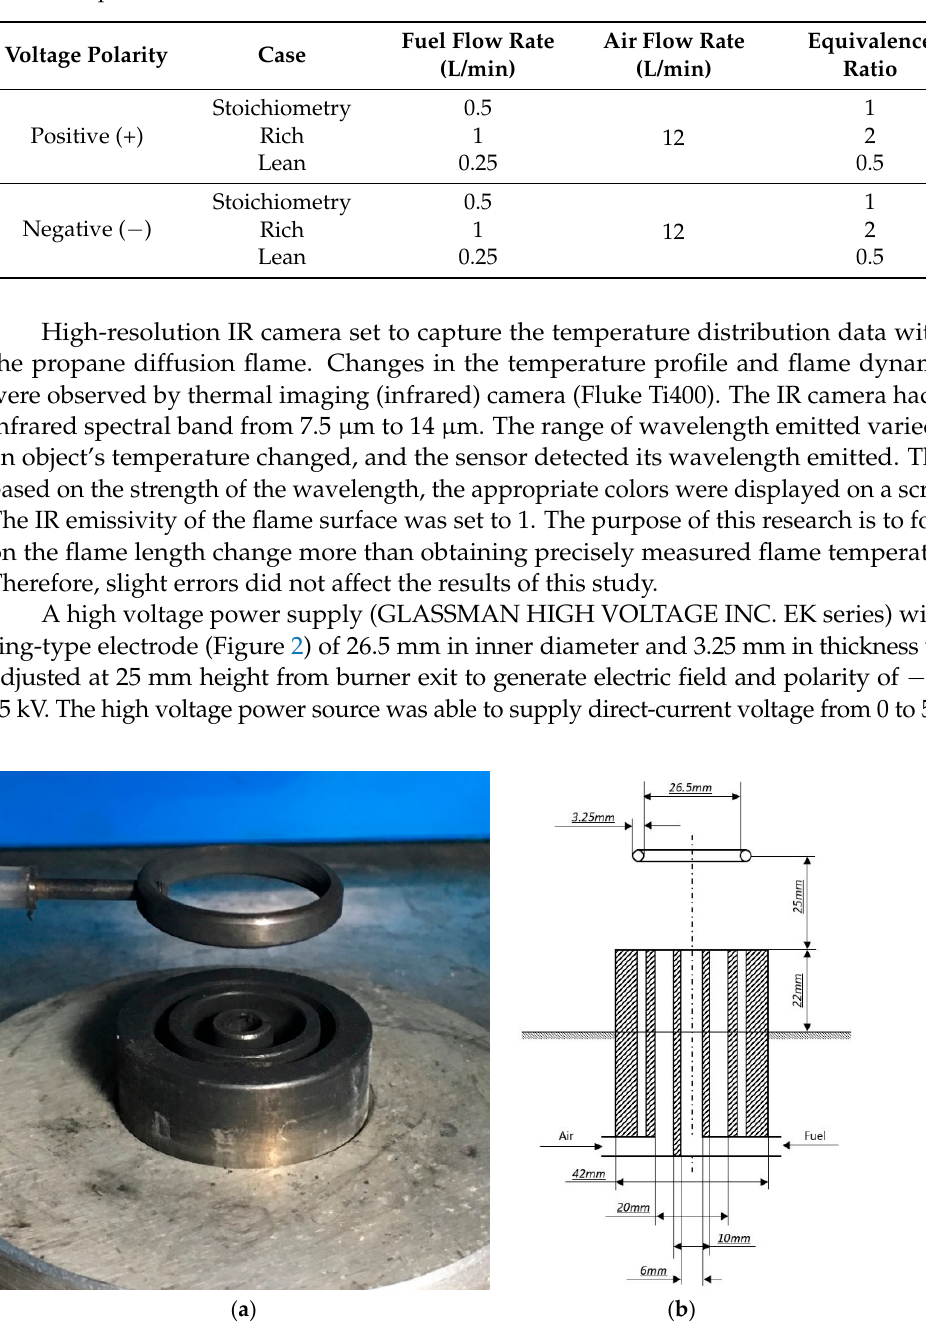
Table 1. Experimental conditions.